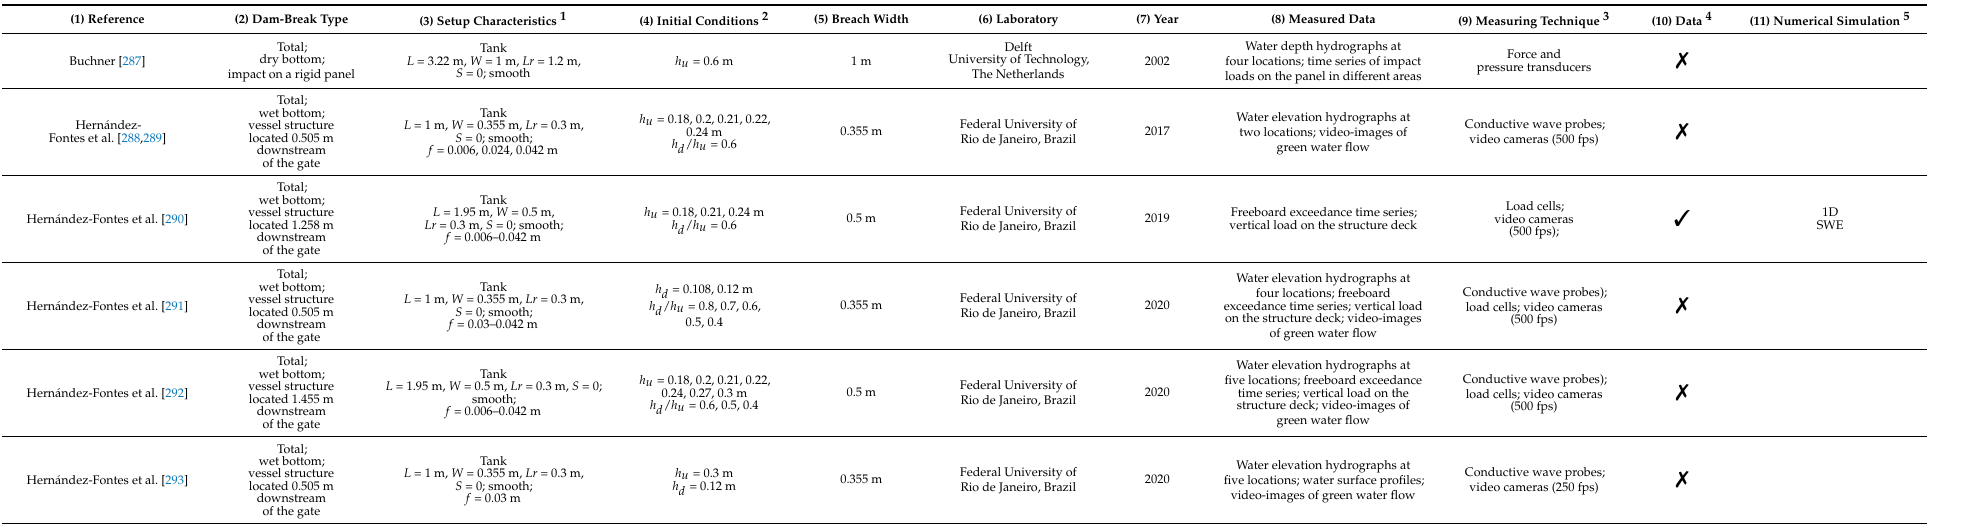
Table 6. Experimental investigations on green water events using dam-break waves.